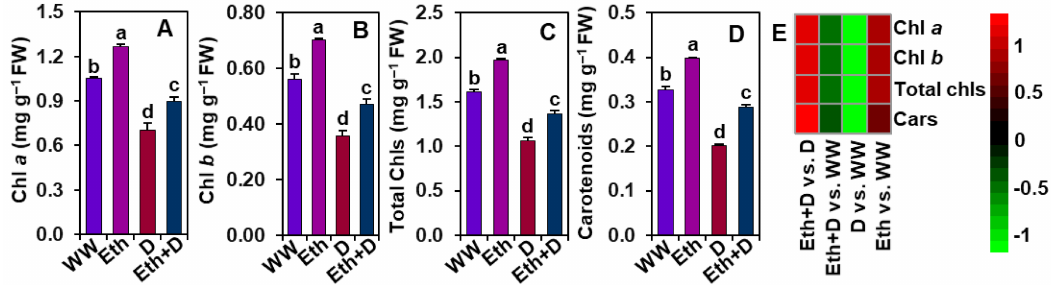
Figure 3. Effect of exogenously supplied 20-mM ethanol on ( A ) Chl a , ( B ) Chl b , ( C ) total Chls, and ( D ) carotenoid contents in the trifoliate leaves of soybean plants subjected to drought stress for a period of 8 days. ( E ) Heatmap of the fold-change values of the aforementioned parameters in soybean plants under different treatments. Bars represent means with standard errors ( n = 4). Different letters shown above the bars are used to indicate significant differences among the treatments ( p < 0.05). WW, Eth,